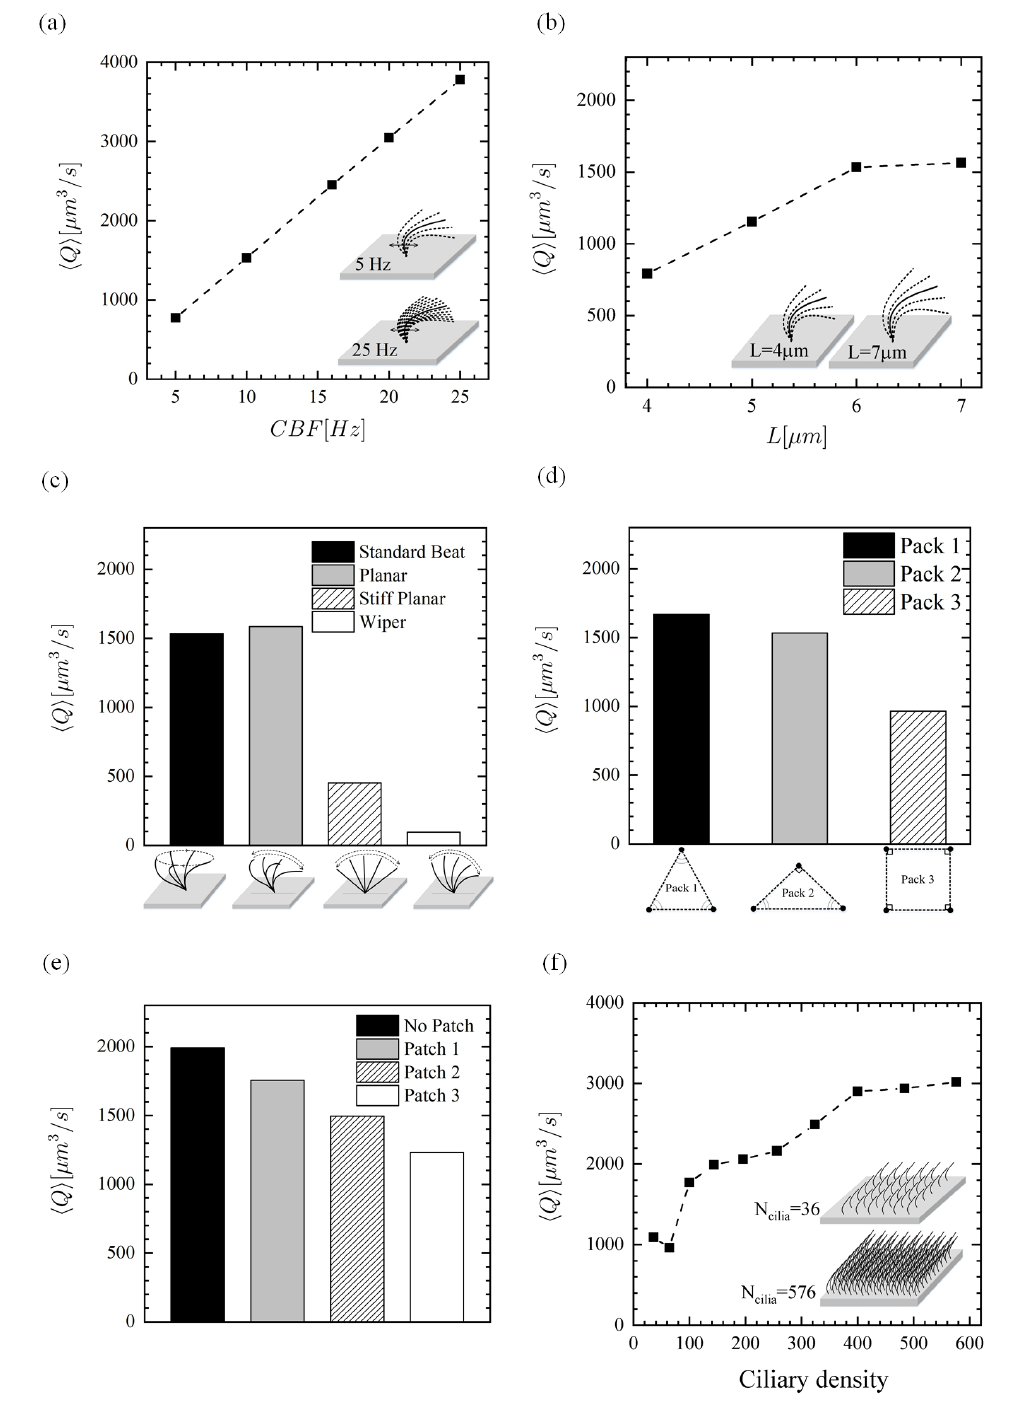
Figure 8. Time-averaged PCL flow rate. Effect of ( a ) beat frequency, ( b ) length of cilia, ( c ) ciliary beat pattern, ( d ) ciliary pack, ( e ) missing ciliary patch, and ( f ) ciliary density (number of cilia over the ciliated